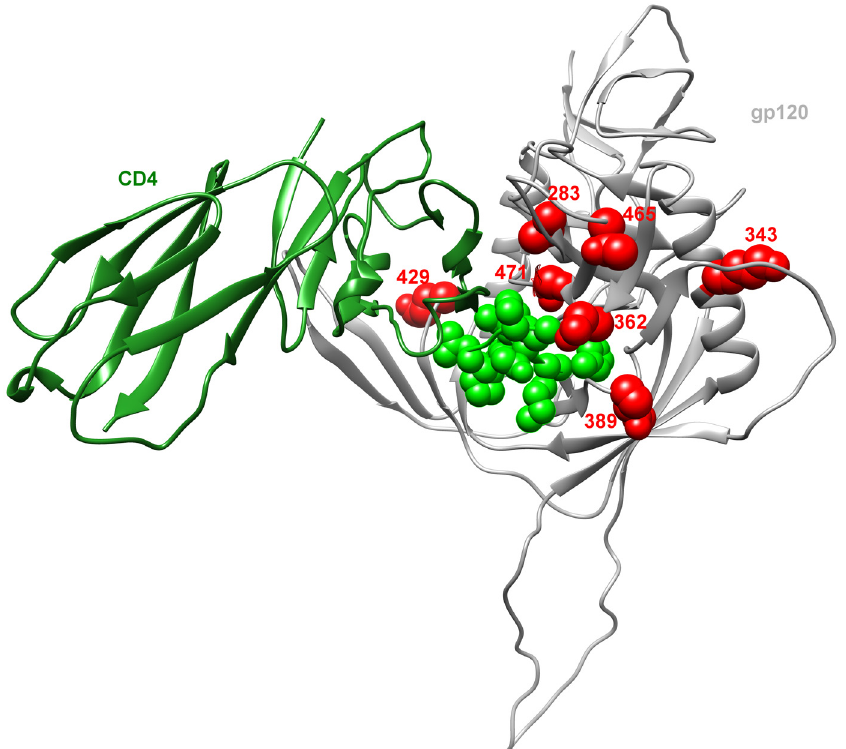
Fig 6. Mapping of signature sites on the three-dimensional structure of gp120 shows clustering around the CD4-binding site. A ribbon representation of the crystal structure from the JRFL gp120 molecule (grey) bound to CD4 molecule (green) (PDBID: 2B4C). The CD4 binding site is highlighted in transparent green while signature sites 283, 343, 362, 389, 429, 465 and 471 are all depicted as red space-filling